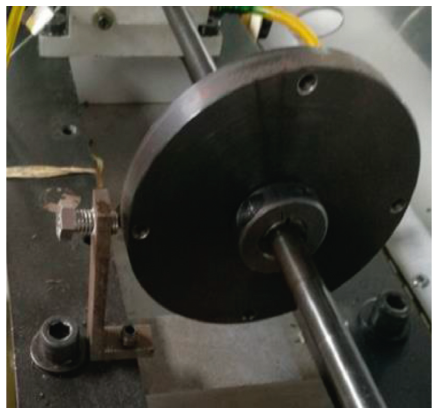
Figure 16: The schematic diagram of rubbing